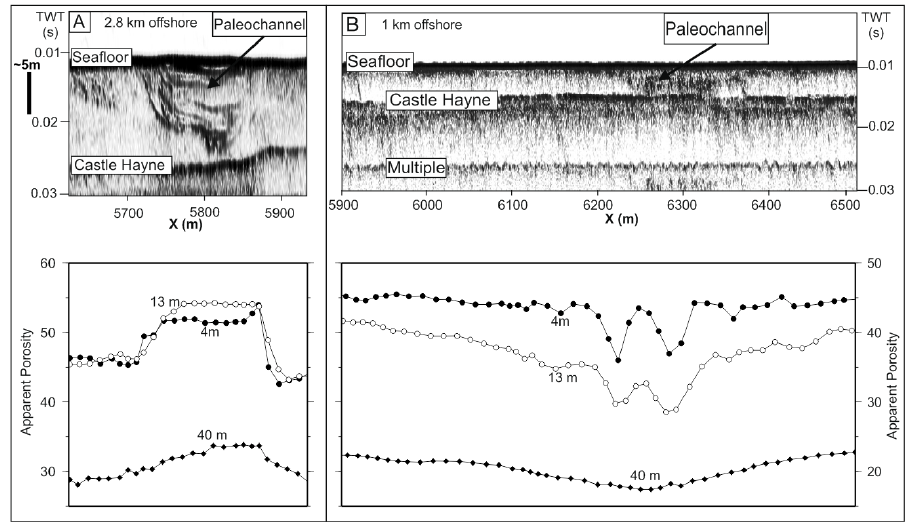
Figure 3. Example of combination of high resolution seismic data (CHIRP seismic profiles, upper panels) and electromagnetic data (as apparent porosities, lower panels) illustrating the offshore extent of a paleochannel with no seabed expression and its relationship with groundwater (modified from Reference [74]). The data are from offshore North Carolina. In ( A ) (2.8 km offshore) the channel geometry is visualized through seismic data as concave upwards high amplitude reflections between the seabed and 0.025 s TWT. The related EM response of the channel shows an increase in porosity reflecting coarser grained material within the channel, particularly at the channel floor. ( B ) Transect located 1 km offshore, where the channel is located between the seabed and 0.015 s TWT, with an EM response more complex than ( A ), with an initial drop in porosity at the channel flanks, followed by an increase in mid-channel. The 40-m receiver shows a smooth decrease in porosity starting about 100 m either side of the channel. In the seismic sections, 6ms corresponds approximately to 5 m; resolution of data, considering frequency of 1–7 kHz and a typical shallow siliciclastic sediment velocity of 1600–1800 m/s, is in the order of few 10 s of cm.